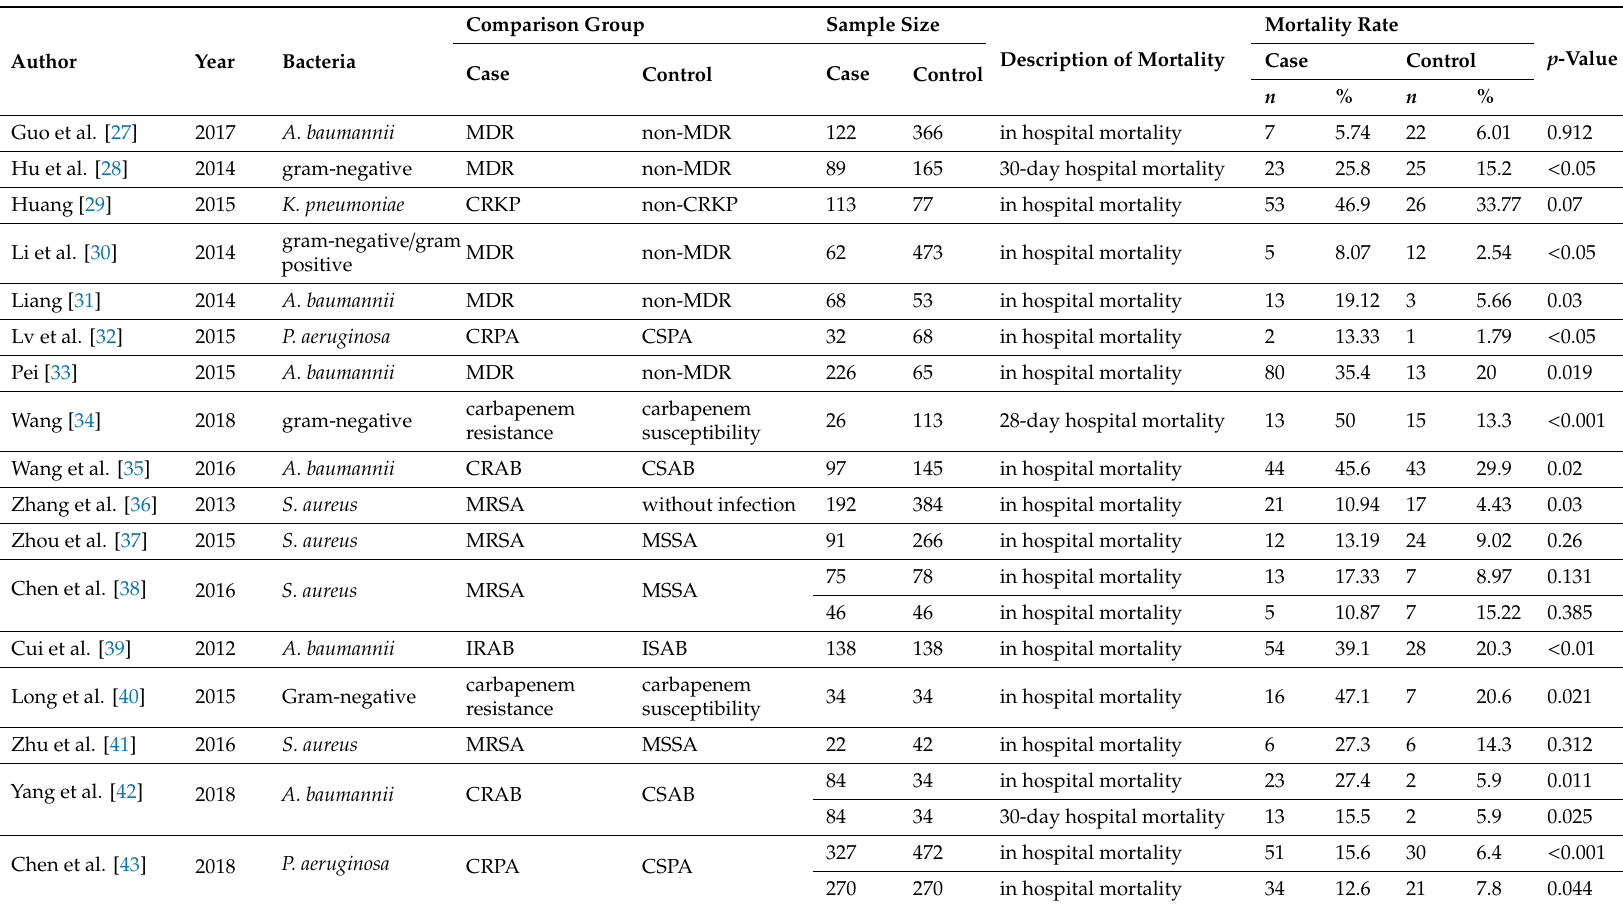
Table 1. Studies describing hospital mortality among inpatients with antibiotic resistance and multi-drug